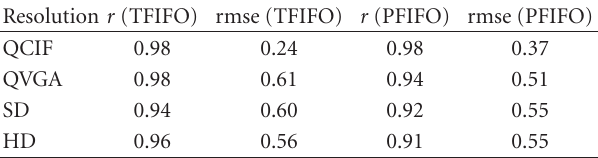
Table 10: Accuracy results for TFIFO and PFIFO